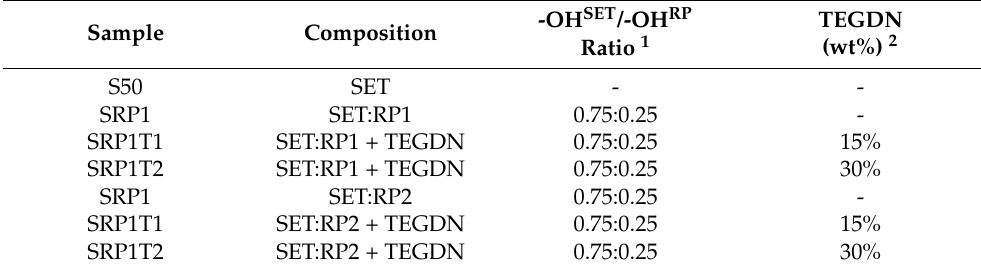
Table 1. The composition of the investigated